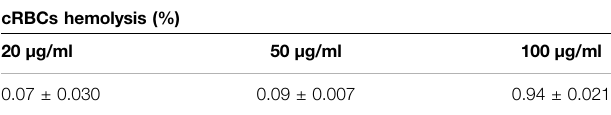
TABLE 3 | The pH stability assay and cumulative protein release assay of the synthesizedCNPvaccine.TheCNPwasincubatedin1×PBSatmultiplepH ’ s for 6 h.